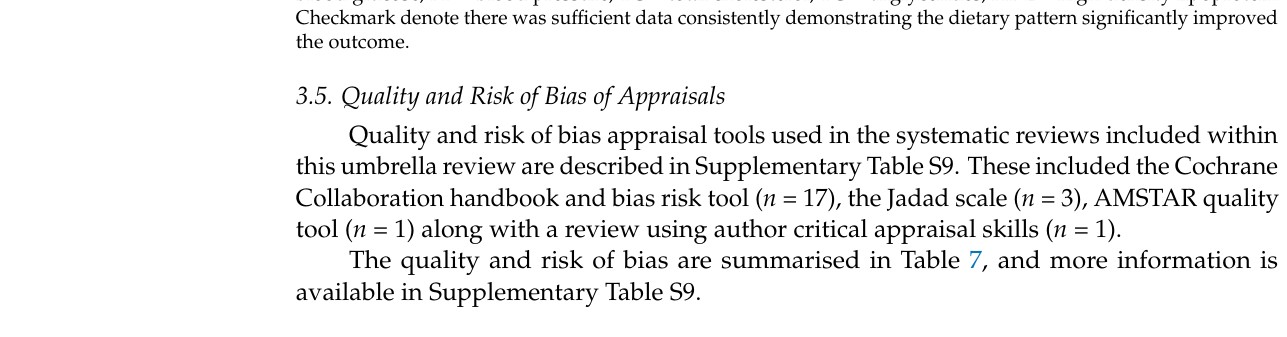
Table 7. Quality and risk of bias from systematic reviews with